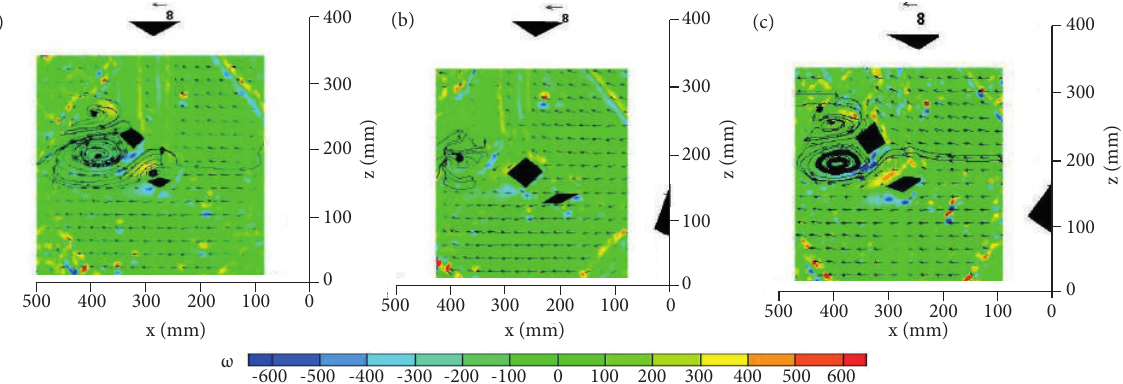
Figure 22. Vorticity contours and velocity vectors varying the inclination of coastal cliff for y/L = 0.29, α = 45° and Re = 1.7 × 10 5 .